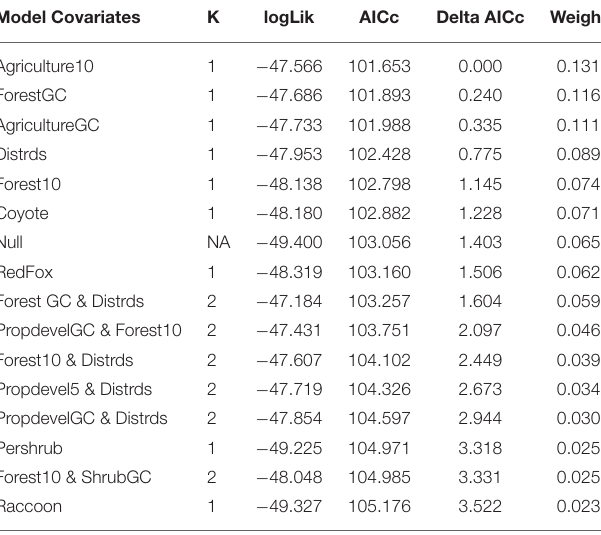
TABLE 2 | Candidate model set for L. rufus